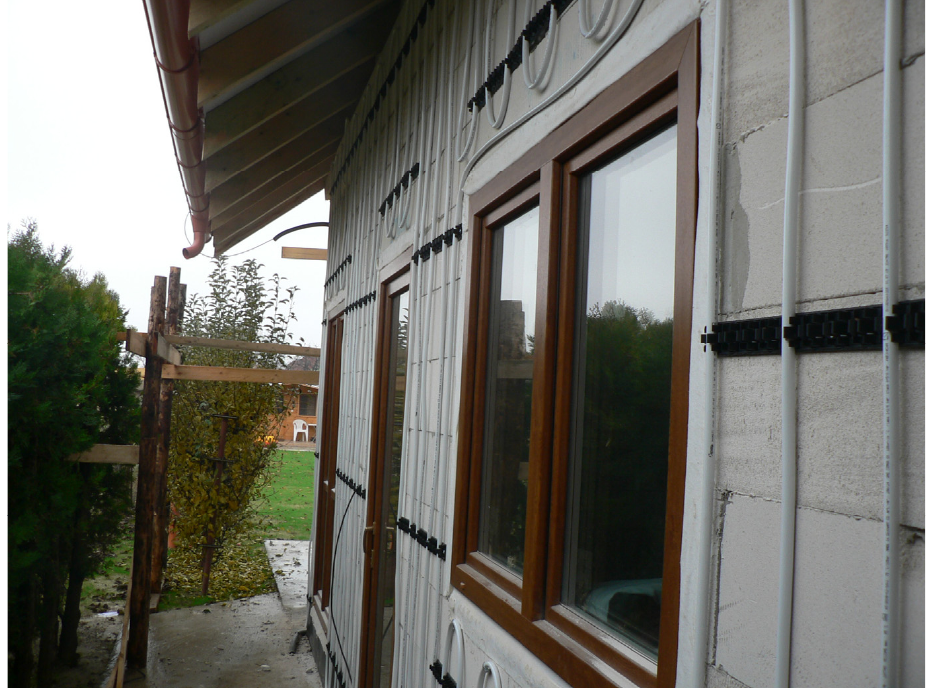
Figure 21. View of the ATP formed by a plastic pipe between aerated concrete masonry and polystyrene. (Photo archive: Kalús).